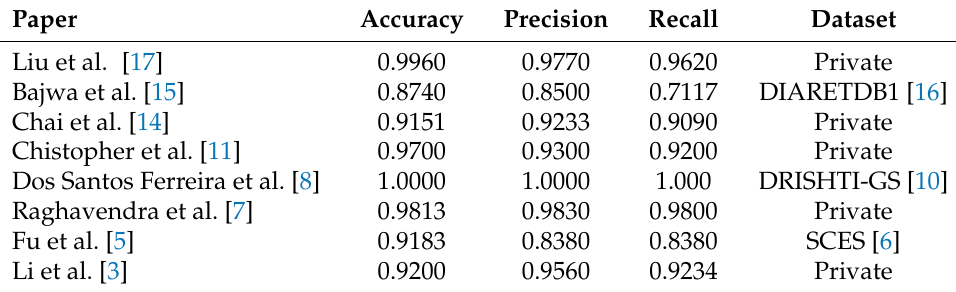
Table 1. Results obtained from the state of the art (higher is better